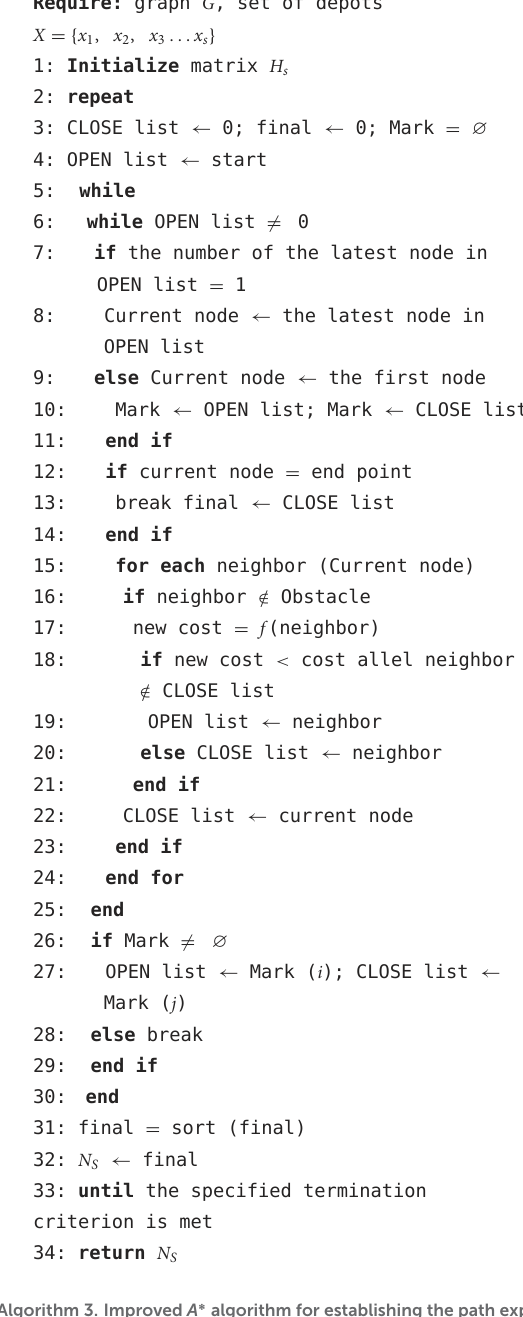
by Zhou et al. (2012) with good global search capability and convergence property. In our proposed HDSTA, the integrated problem is decomposed into individual elements and the individual S is defined by three “state spaces” related to its tasks sequence, AGV dispatch, and the corresponding routes, as depicted in Figure